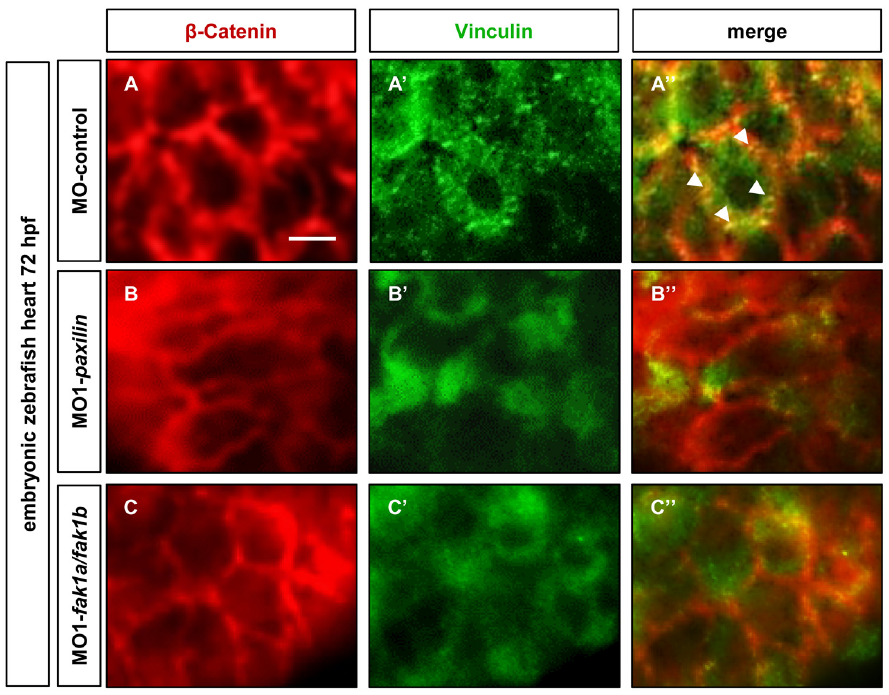
Fig 5. Vinculin does not localize to focal adhesion sites in Paxillin- and FAK-deficient zebrafish embryos. (A-C) Co-immunostaining of dissected embryonic (72 hpf) zebrafish hearts with antibodies against β -Catenin (red) and Vinculin (green) of control- (A), MO1- fak1a/fak1b- (B) and MO1- paxillin - (C) injected hearts. Arrow heads indicate focal adhesion sites. Scale bar 5 μ